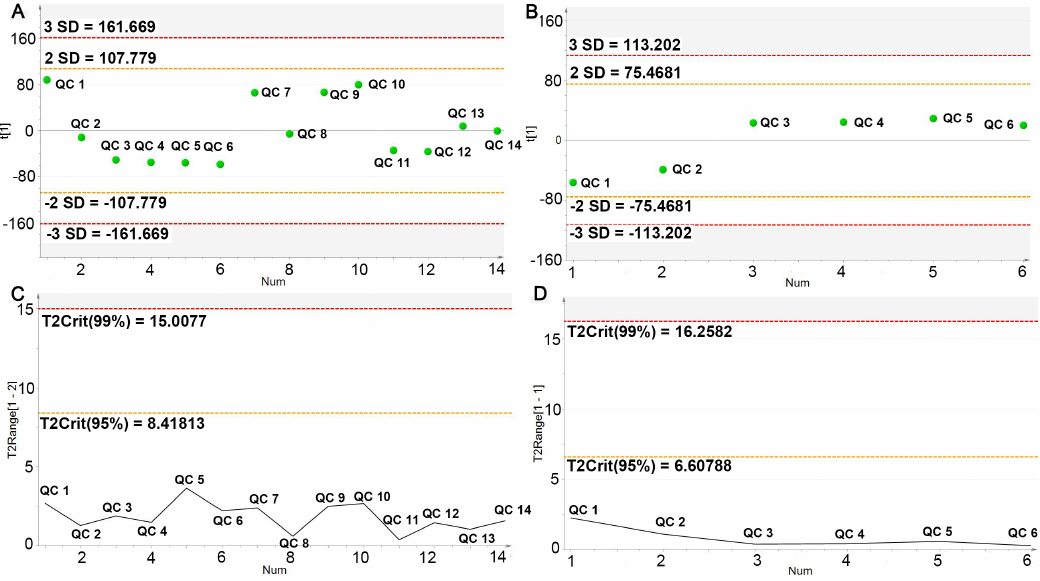
Figure 3. PCA line score plots of different injections of quality control (QC) sample. X-axis represented the run order of QC sample; Y-axis represented standard deviation ( A , B ) and Hotelling’s T2 range ( C , D ), separately. ( A , C ) for ESI + mode; ( B , D ) for ESI − mode.